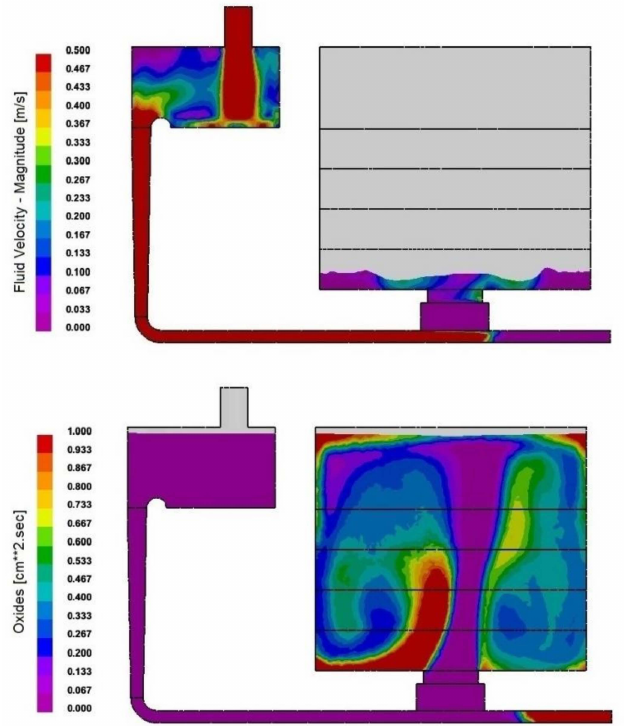
Figure 7. Simulations of the melt velocity and amount of oxides in the naturally pressurized gating system with 20 ppi foam